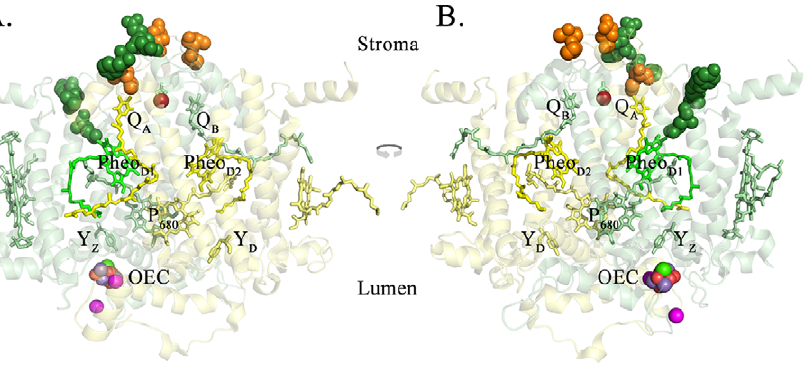
Figure 2. Oxidized Residues Identified on the Stromally Exposed Regions of the D1 and D2 Proteins in the Vicinity of Q A and Pheo D1 . The T. vulcanus residues corresponding to the oxidatively modified spinach residues (Table 1) are highlighted. These oxidized residues are shown as spheres superimposed on monomer I of the T. vulcanus structure. For clarity, only the D1 and D2 proteins and their associated cofactors are shown. A. the view from outside Monomer I, looking towards the dimeric complex from within the plane of the membrane. B. the view from Monomer II looking towards its interface with Monomer I within the plane of the membrane. The D1 protein is shown in pale green and the D2 protein is shown in pale yellow. The oxidatively modified residues of D1 are shown in dark green while those of D2 are shown in orange. Various cofactors of both D1 and D2 are labeled and colored pale green or yellow, respectively. Pheo D1 is shown in bright green. The non-heme iron is shown in bright red. The Mn 4 O 5 Ca cluster and its associated chloride ions are labeled as the OEC. Figs. 2–4 were produced using PYMOL [53]. doi:10.1371/journal.pone.0058042.g002 PLOS ONE |